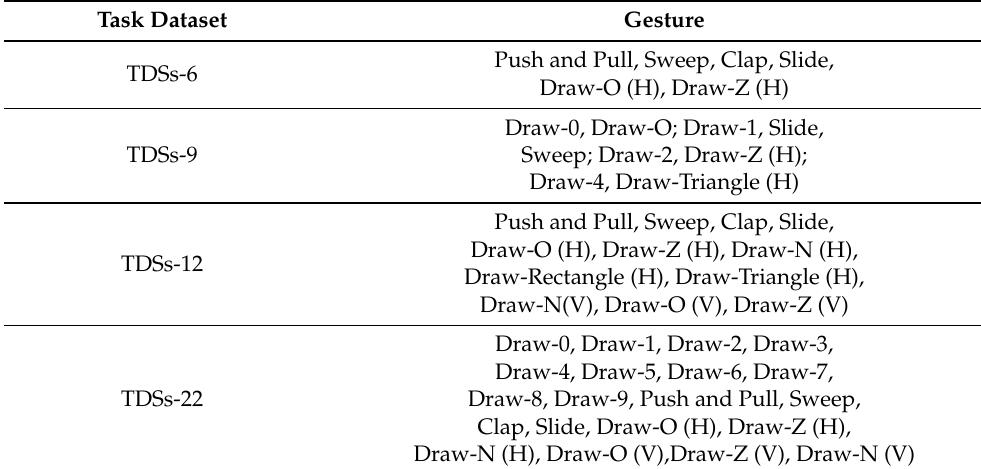
Table 4. Four task datasets and the corresponding gesture